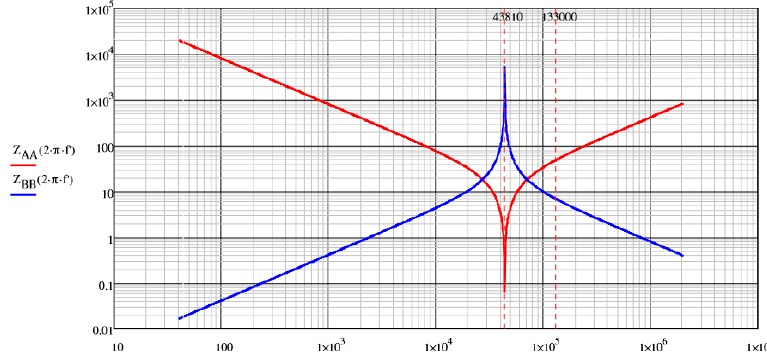
Figure 2. Magnitudes of the impedances seen from terminals A 1 , A 2 , Z AA and B 1 , B 2 , Z BB given as the functions of the frequency for the designed filter.